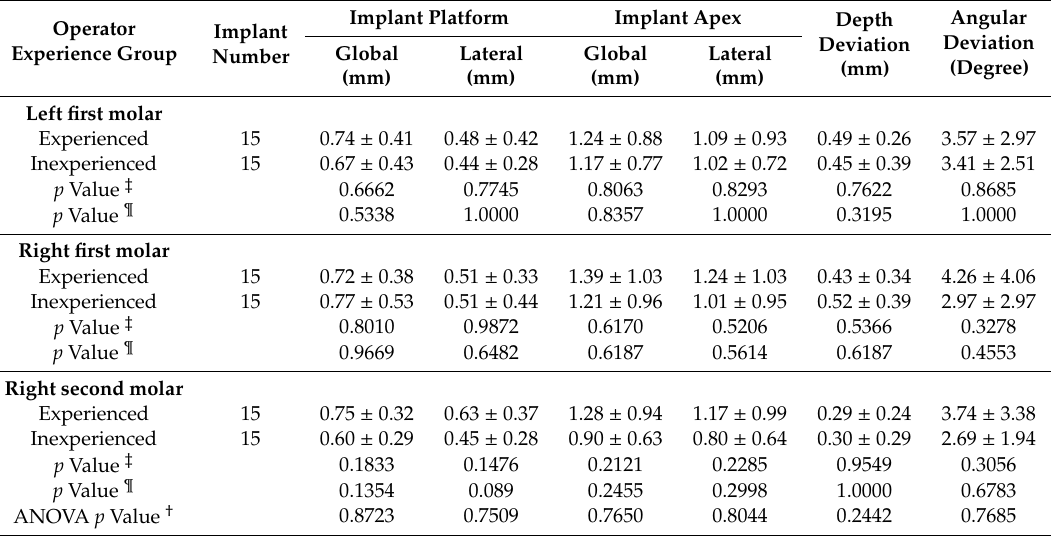
Table 3. Deviations between planned and placed implant position according to implant